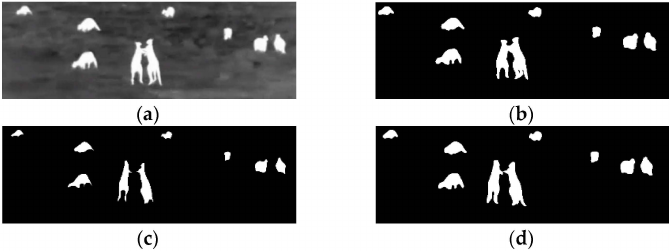
Figure 7. Output from PIT algorithm: ( a ) Original footage ( b ) Image binarized ( c ) Erode operation result ( d ) Dilation operation result.